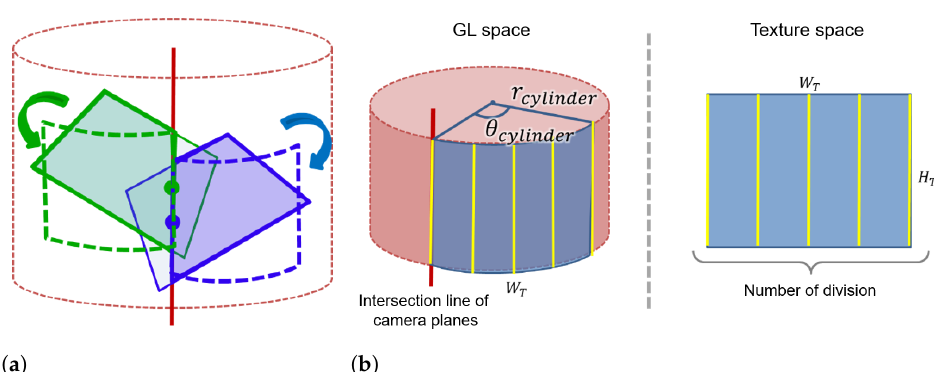
Figure 8. Constructing the expanded view using cylindrical projection: ( a ) is an overview of the projection method and ( b ) illustrates the approximation of the cylindrical surface by texture